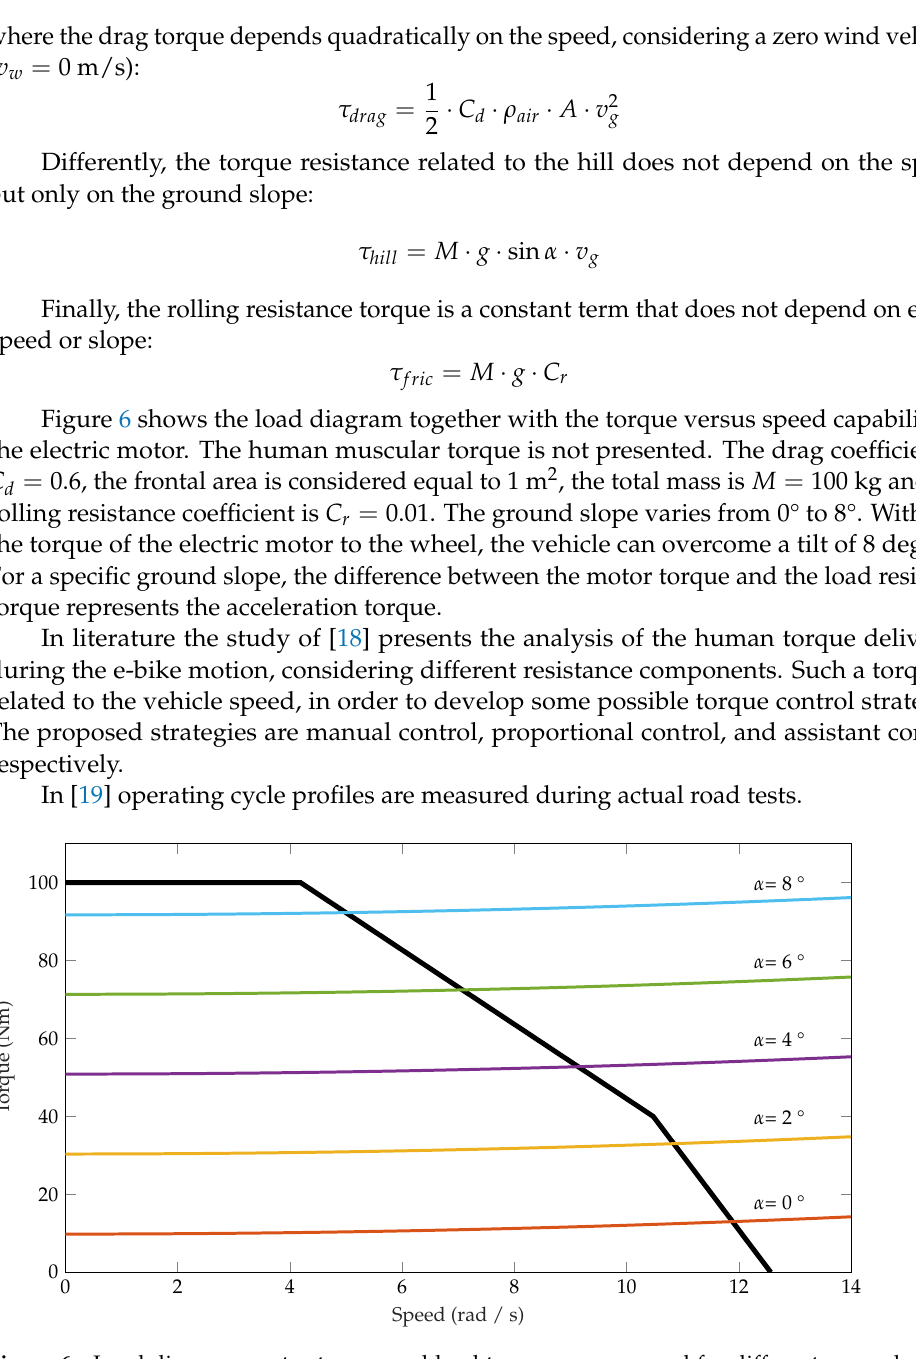
Figure 6. Load diagram, motor torque and load torque versus speed for different ground slopes (without the rider muscular